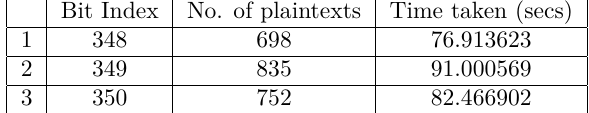
Table 2: No. of plaintexts and total time taken for the bit indices 348, 349 and 350 during template matching